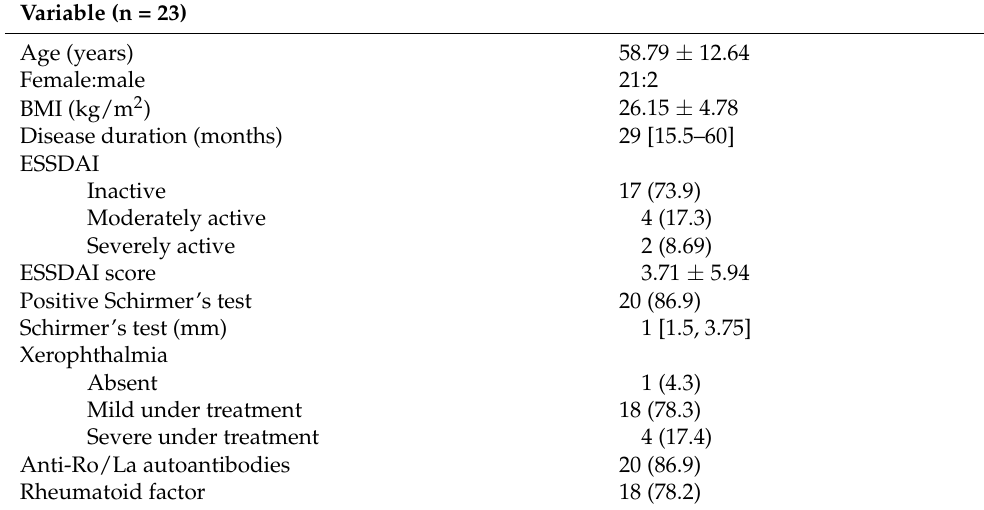
Table 1. Descriptive data of the pSS